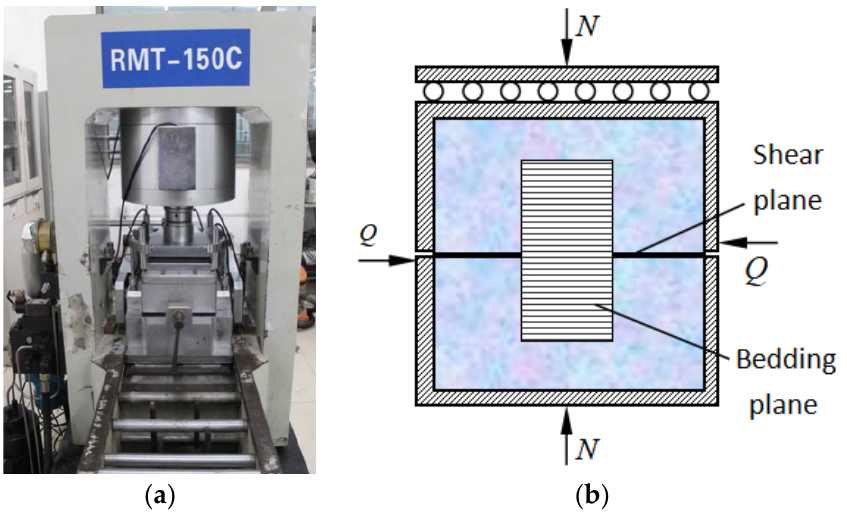
Figure 4. RMT-150C rock mechanics experimental system and principle of direct shear test. ( a ) RMT-150C rock mechanics experimental system; ( b ) Principle of direct shear test.